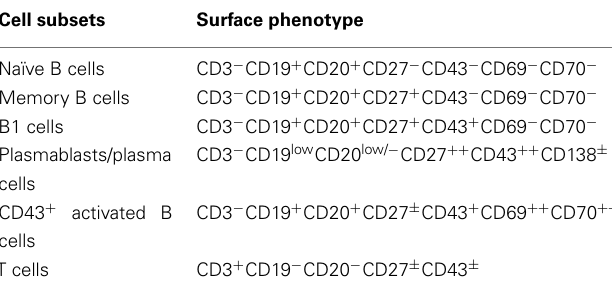
Table 1 | Surface phenotype of major lymphocyte